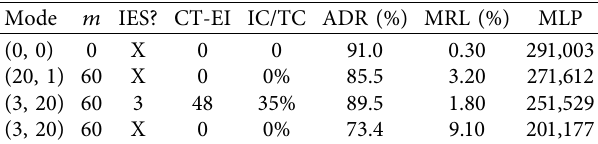
Table 1: Operational performance of the virtual dual-source purchasing inventory system.